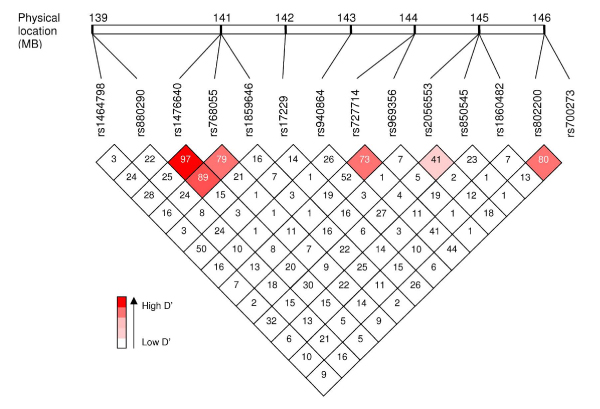
LD structure of 14 Illumina SNPs within the 1-LOD unit drop support interval for the QTL on chromosome 7 initially reported by Jones et al. [7].